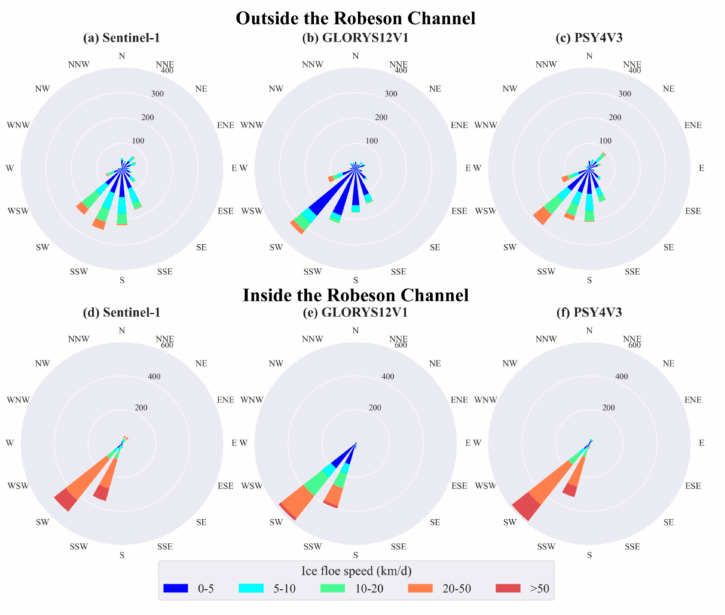
Figure 8. Rose diagrams for inside and outside the Robeson Channel for ( a , d ) all the ice floes from Sentinel-1, ( b , e ) the corresponding ice motion from the GLORYS12V1 product, and ( c , f ) the corresponding ice motion from the PSY4V3